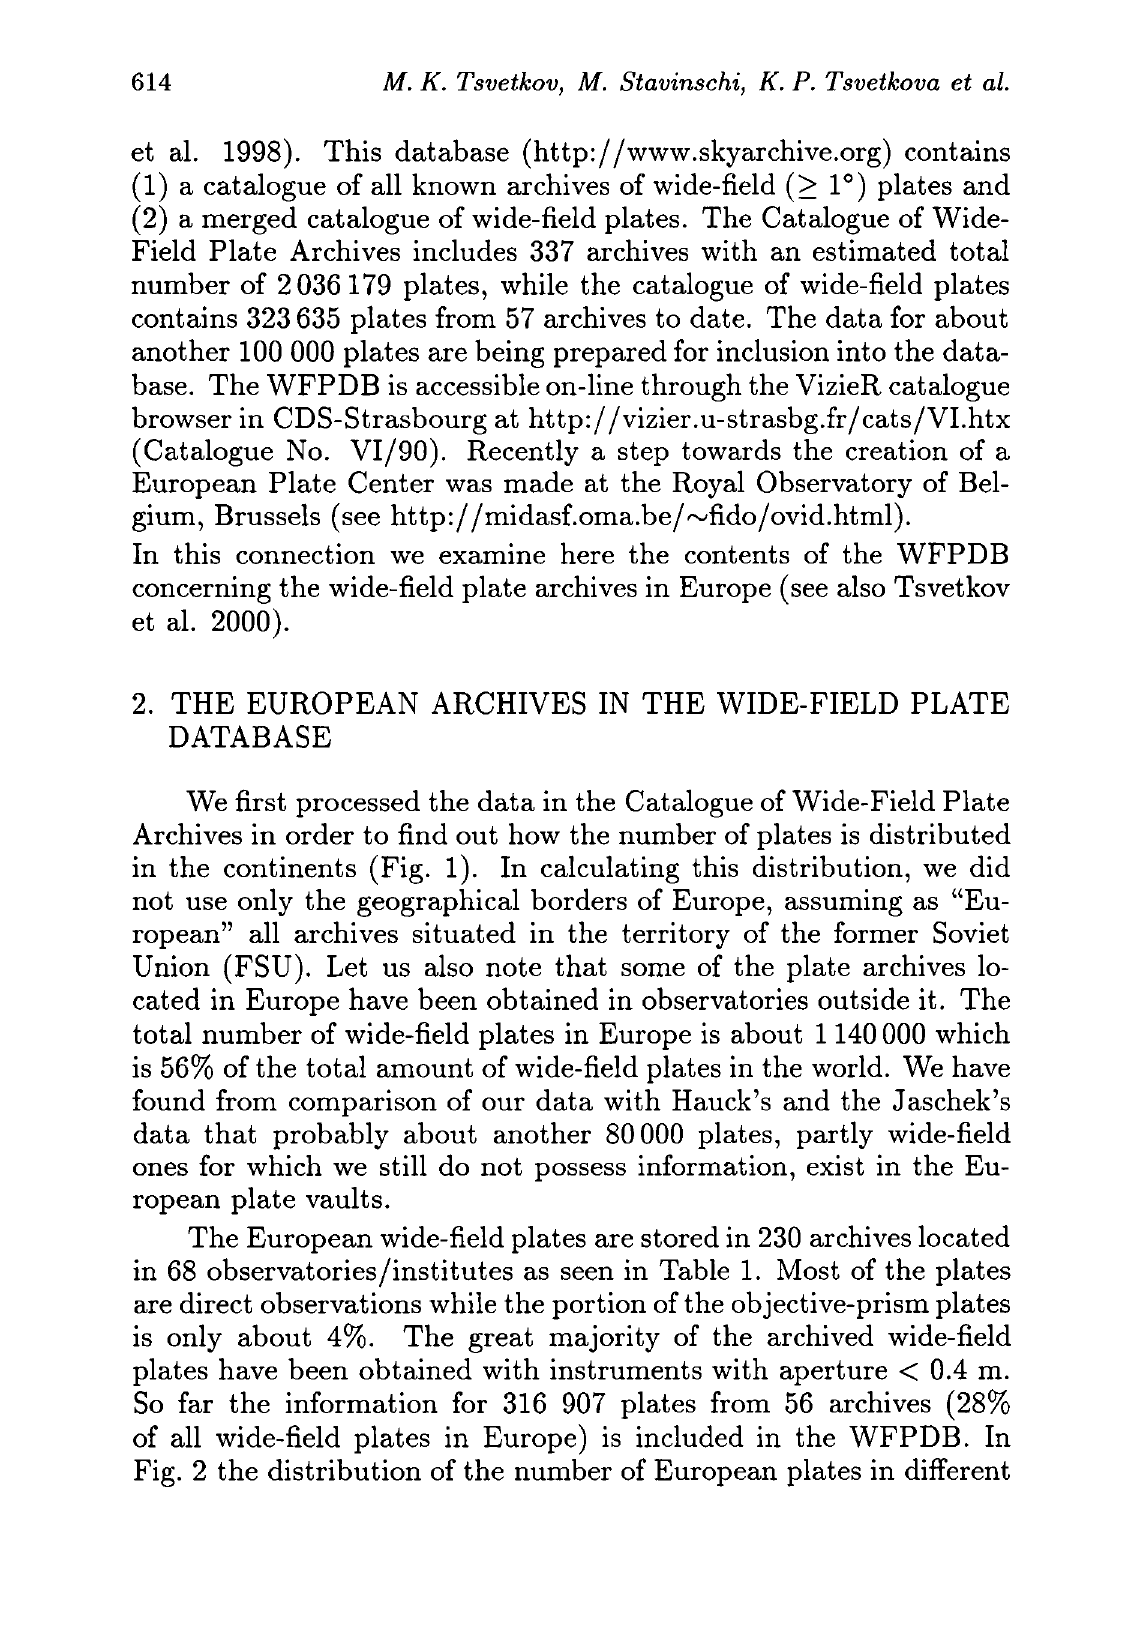
Fig. 2 the distribution of the number of European plates in